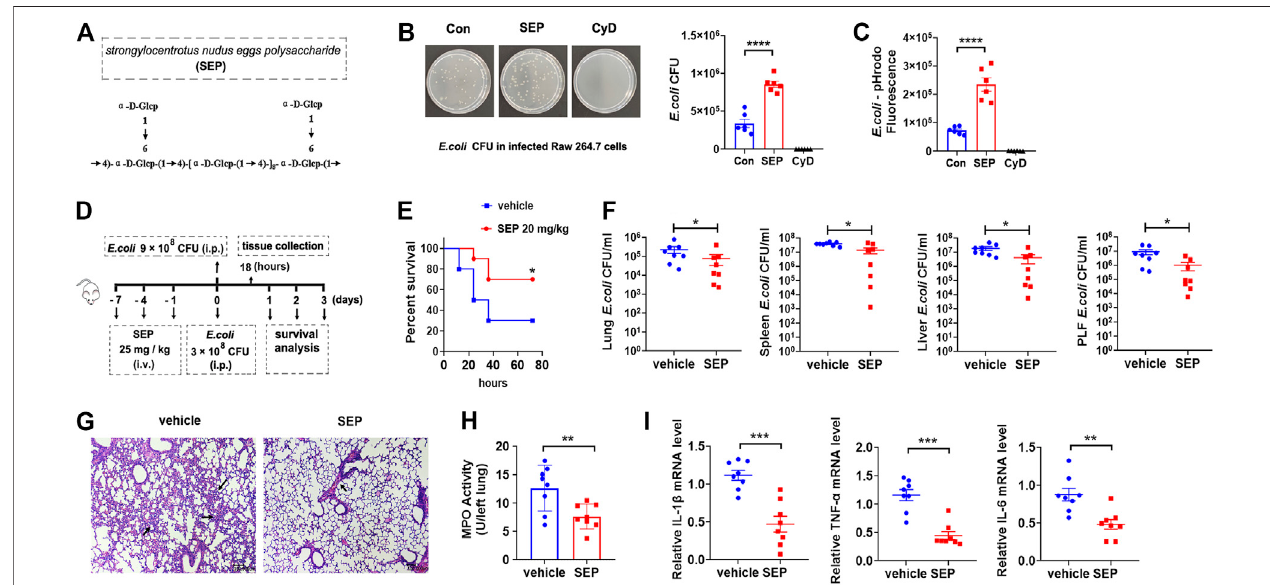
FIGURE1| SEP protects against E.coli infection byenhancing hostdefense. (A) Molecularstructure ofSEP. (B) The effect ofSEP onmacrophagesphagocytosis of live E. coli by gentamicin protection assay. RAW264.7 cells were administrated with Cyt D (10 μ M) for 2 h prior to E. coli infection. (C) The effect of SEP on macrophages phagocytosis by fl uorescence intensity. RAW264.7 cells were fed with pHrodo-conjugated inactivated E. coli bioparticles for 1 h and phagocytosis was quanti fi ed by the fl uorescence. (D) The experimental design of E. coli infection and SEP treatment in mice. Mice were pre-treated with SEP (25 mg/kg) or vehicle (saline)byi.v.every3 daysforthreetimes,andinfectedwith E.coli (9×10 8 CFUpermouse,i.p.)ontheeighthday.Thenthesurvivalofmice (E) wereevaluated.( n =10). (F) Micewerepre-treatedwithSEP(25 mg/kg,i.v.)andinfectedwith E.coli (3×10 8 CFUpermouse,i.p.)ondayeight,thensacri fi cedat18 hpost-infection.( n =8).CFU of E. coli in tissue homogenates of lung, spleen, liver, and peritoneal lavage fl uid were detected. (G) Lung sections were stained with H&E. (H) Myeloperoxidase (MPO) value were detected in the lung tissue. (I) The expression of IL-1 β , TNF- α and IL-6 in the lungs were measured by ELISA. All data are represented as mean ± SEM acquired in triplicate determinations. * p < 0.05, ** p < 0.01, *** p <